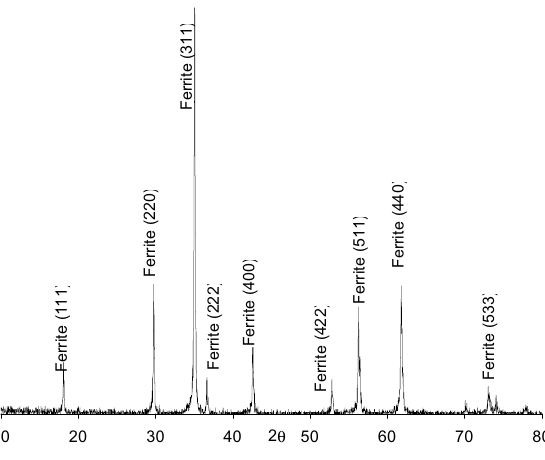
Figure 12. X-Ray diffraction patterns for MnZn ferrite powders.